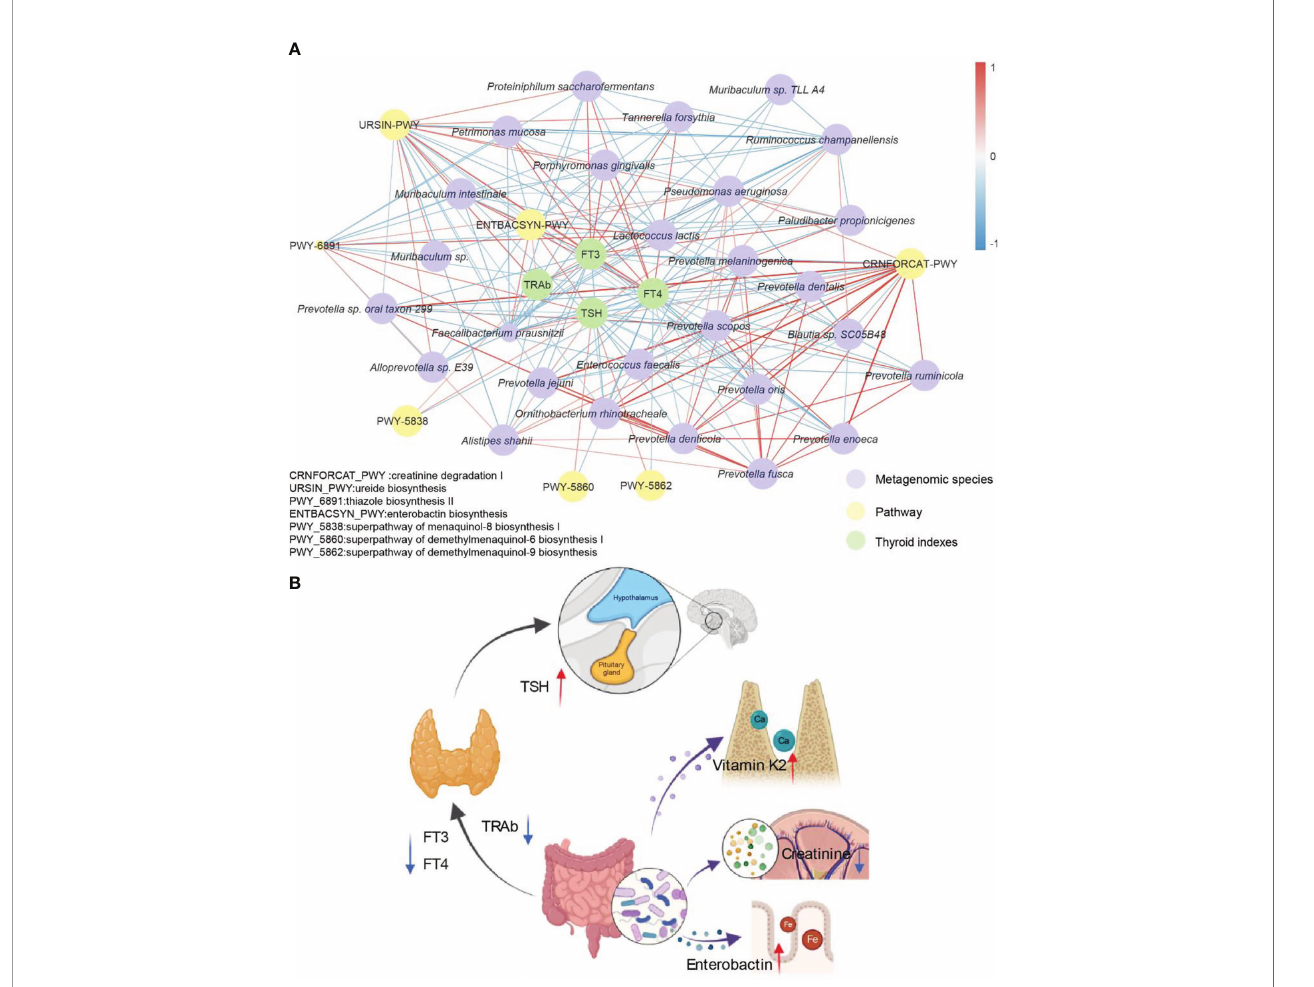
FIGURE 5 | Potential mechanism of interaction between berberine combined with methimidazole and thyroid clinical indexes. (A) Signi fi cantly different strains, metabolic pathways and thyroid function indicators are based on Spearman correlation coef fi cients together to form this correlation network. Edge width and color (positive correlation in red, negative correlation in blue) are proportional to the correlation strength of the co-occurrence probabilities. Node size is proportional to the average abundance of the respective populations. (B) Simpli fi ed visualization schematic with possible mechanisms of action including the gut-hypothalamus axis and the gut-thyroid